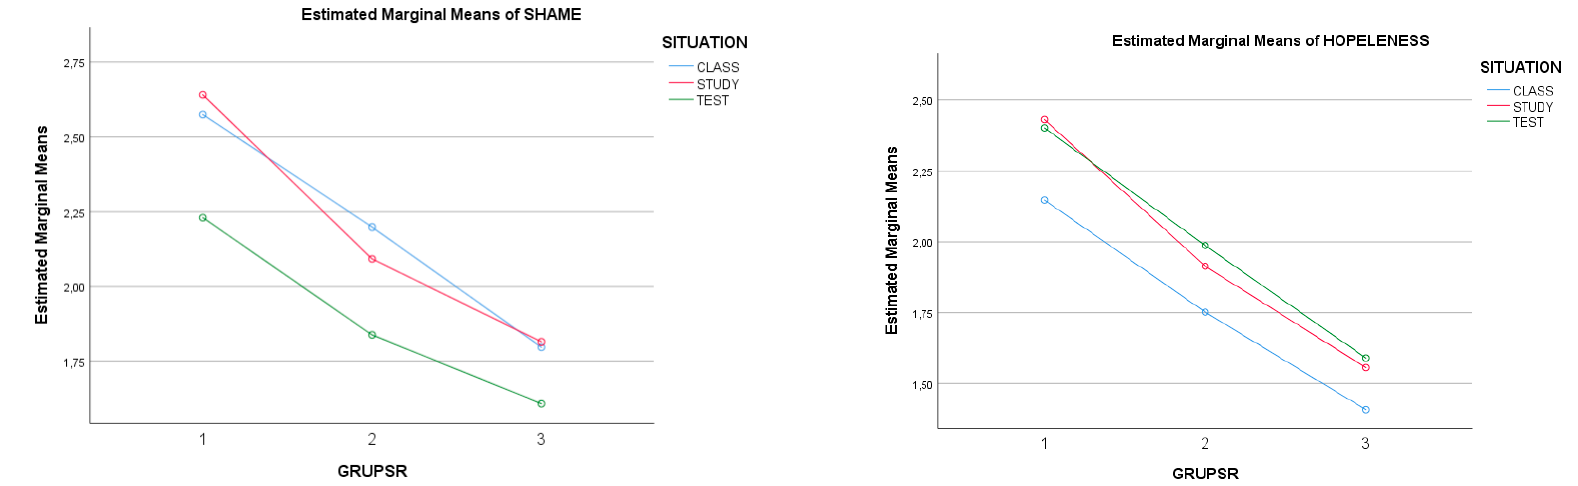
Figure 2. Effects of the SR level and situational stress level for specific achievement emotions. Note : GRPSR= group of level in self-regulation (1 = low, 2 = medium and 3 = high) and SITUATION = class, study and test.